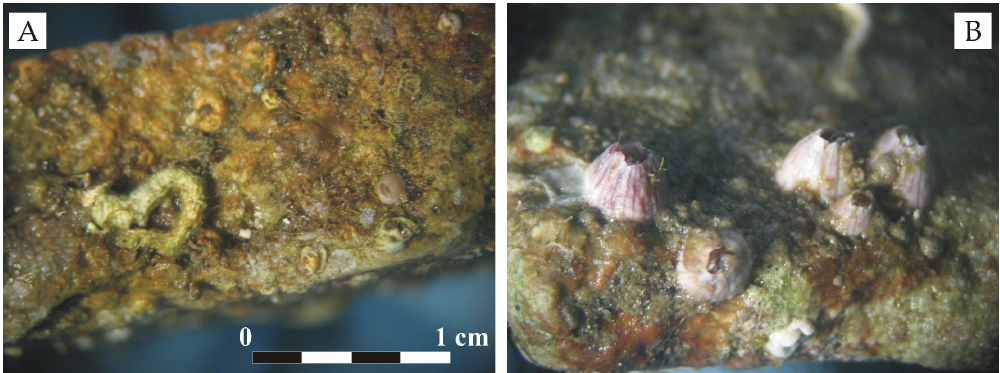
Figure 3. Macroscopic view of specimens: tubeworms ( A ) and barnacles ( B ) are among the most abundant encrusting organisms in the studied samples.